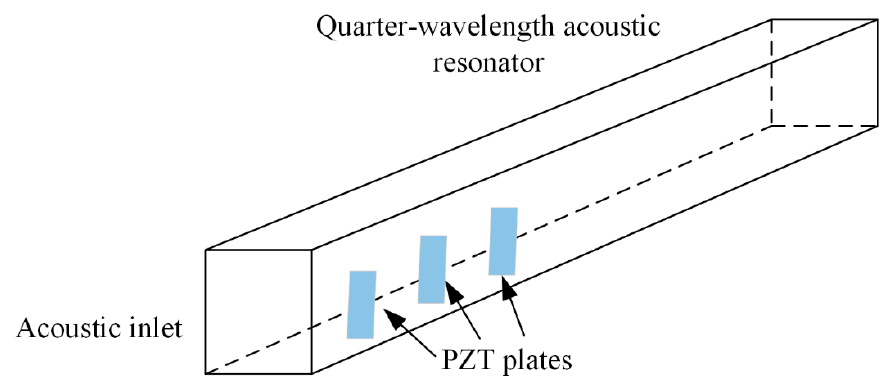
Figure 16. Schematic diagram of quarter-wavelength resonator tube and the installed PZT beams.